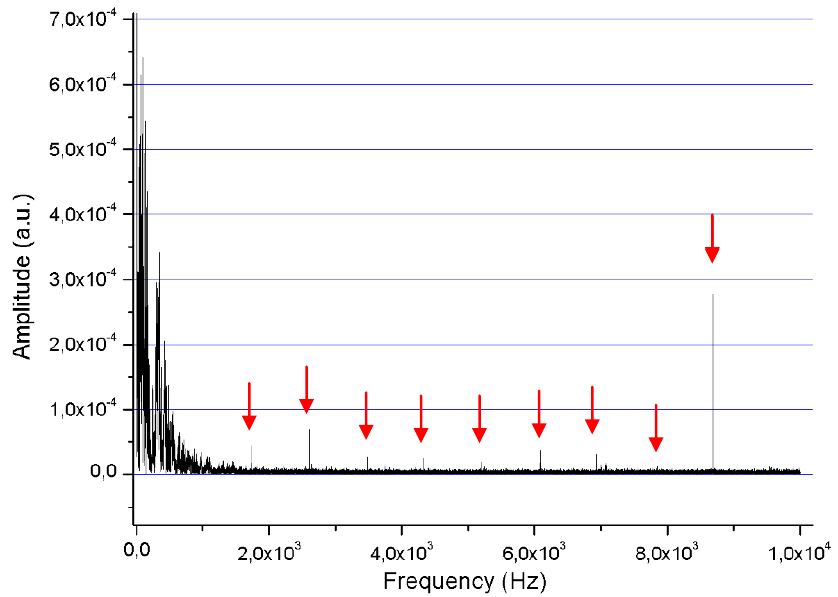
Figure 12. Fast-Fourier-Transform graph for the data collected by the 20 kHz interrogator. Red arrows indicate the most interesting values